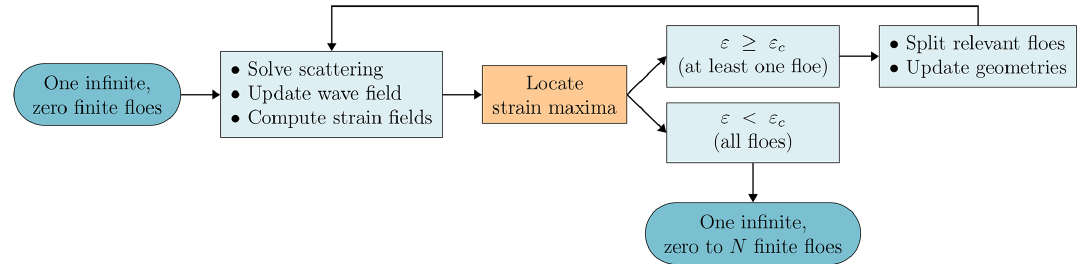
Figure 2. Outline of the numerical experiment.